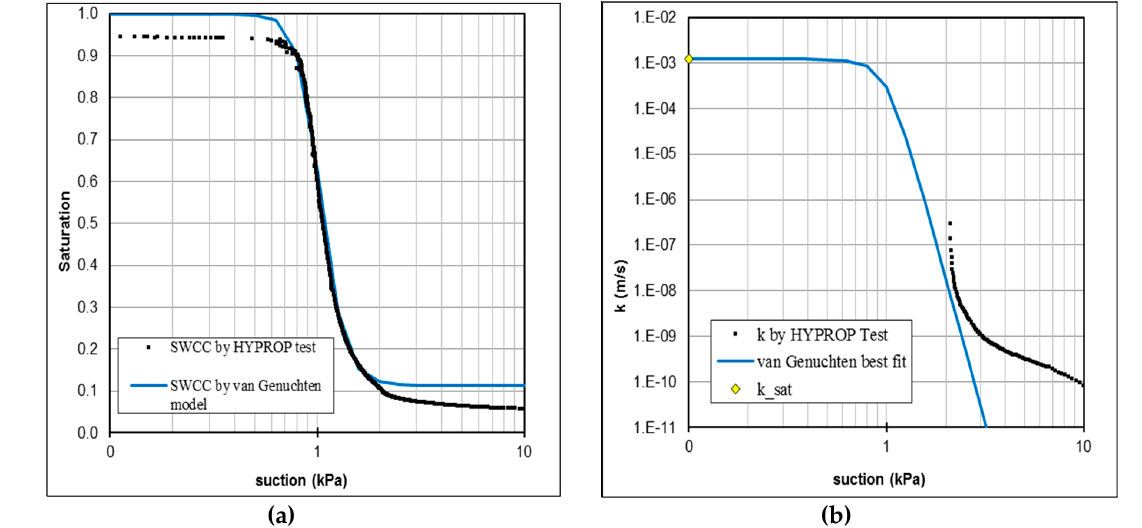
Figure 5. ( a ) Soil Water Characteristics Curve (SWCC). Results for both the HYPROP device test and the van Genuchten approximation are presented; ( b ) relative hydraulic conductivity curve.